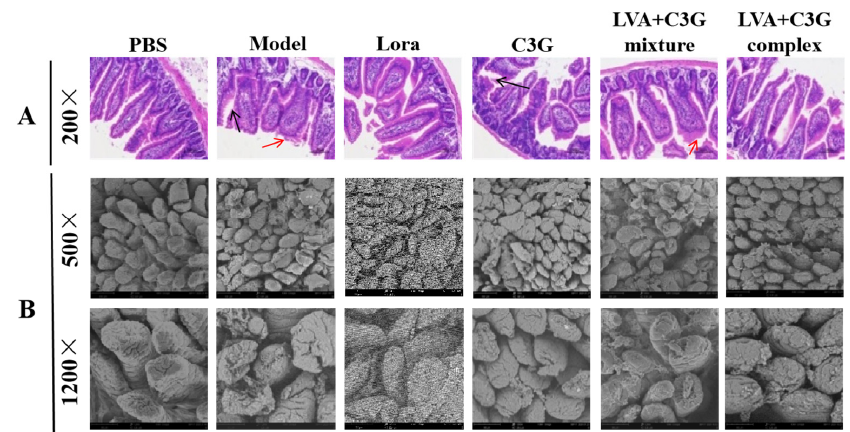
Figure 2. The effect of the C3G-associated samples on the allergic response. ( A ) The scores of the anaphylactic symptoms. ( B ) The rectal temperature of the mice 0 to 1 h after the last challenge. ( C ) Anal, fecal, and intestinal content observations. ( D ) Serum OVA-specific IgE. ( E ) Serum histamine. ( F ) Serum mMCP-. Significant differences ( p < 0.05) are identified by different letters. 3.2. Observation of the Physical Barrier Function of the Intestinal Epithelium Food allergic reactions, especially with diarrhea, are often accompanied by intestinal inflammation. Therefore, this work employed H&E staining and SEM to examine the in- testinal inflammation in OVA-induced FA mice. The H&E staining results showed several signs of morphological damage in the model group, including mucosal atrophy and edema, irregularly shaped villi, and crypt hyperplasia (Figure 3A). Moreover, SEM re- vealed ruptured jejunal villi surfaces and increased local damage in OVA-allergic mice (Figure 3B). However, this morphological damage was effectively attenuated in the C3G- associated samples, especially in the LVA + C3G complex treatment group. The villus length to crypt depth (V/C) ratio was calculated to quantify the altered jejunal morphol- ogy. The V/C ratio of the jejuna in the model group (3.08 ± 0.18) was significantly ( p ˂ 0.05) lower than in the PBS group (4.81 ± 0.18) (Figure 3C). After C3G, LVA + C3G mixture, and LVA + C3G complex administration, the V/C ratio increased to 3.64 ± 0.30, 3.22 ± 0.10, and 4.30 ± 0.15, respectively. In addition, the activity of the Na + -K + -ATPase was detected. As depicted in Figure 3D, the Na + -K + -ATPase activity in the model group was significantly ( p ˂ 0.05) lower than in the PBS group. The LVA + C3G complex exhibited a distinctly better ameliorative effect in restoring the Na + -K + -ATPase activity than C3G and the LVA + C3G mixture.